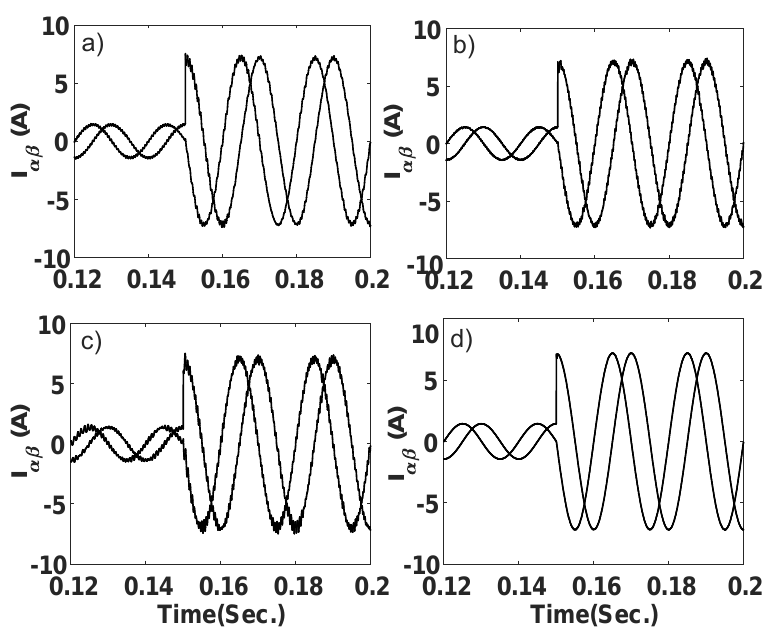
Figure 17. Obtained experimental results for the dynamic response of the VSC using the proposed CFs, load step from 270 W to 1900 W, where ( a ) is the dynamic response for (N-IMPC) strategy, ( b ) periodic (P-IMPC), ( c ) simple penalization (SP-IMPC), and ( d ) without frequency control (IMPC).